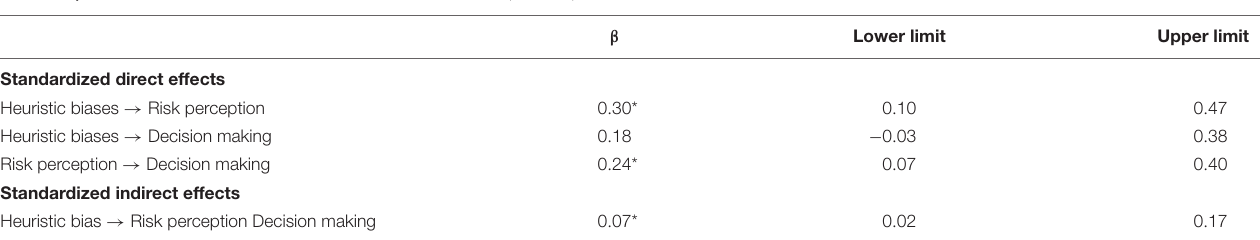
TABLE 3 | Direct and indirect effects and 95% confidence intervals (model